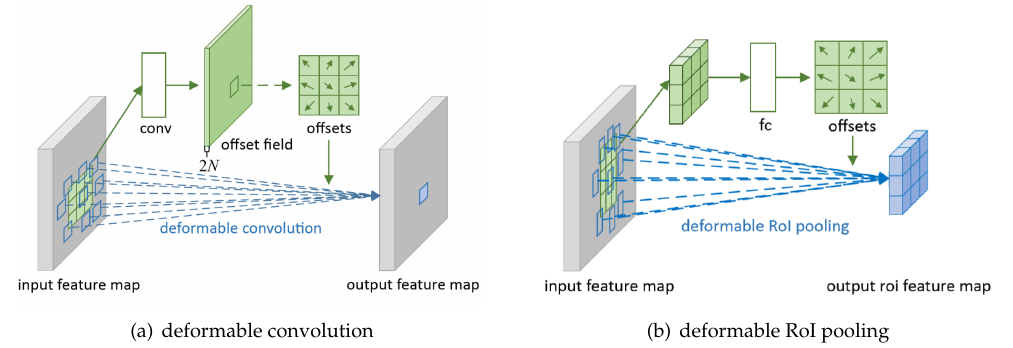
Figure 4. The framework of DCN. Conv, convolutional network; RoI, region of interest; fc, fully connected